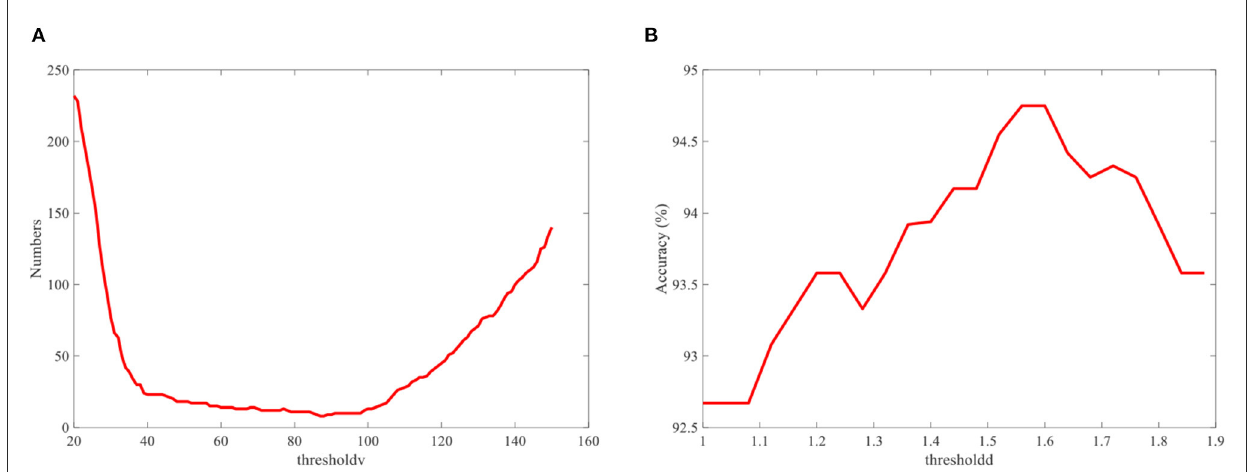
FIGURE9 (A) Relationship between the number of misjudgments and the thresholdv . (B) Relationship between the classification accuracy of the hybrid system and the thresholdd